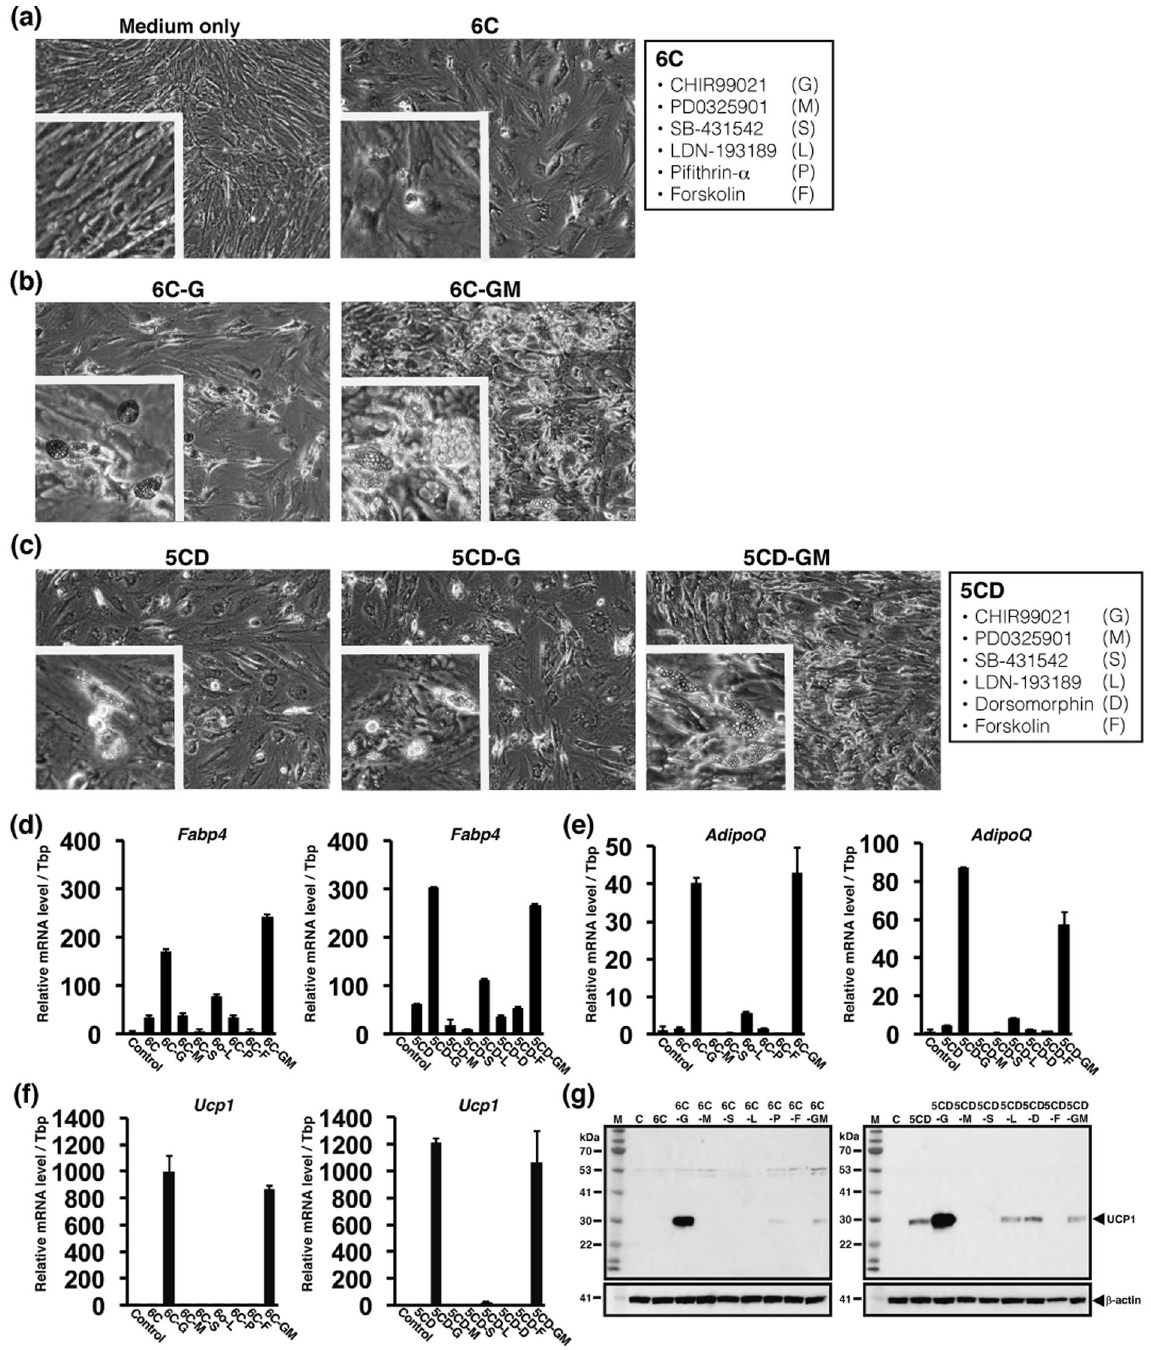
Figure 1. Identification of chemical compounds for direct conversion from HDF38 fibroblasts to adipocyte-like cells. Effects of chemical compounds were evaluated 3 weeks after the treatment. ( a ) Images after the treatment using the adipocyte medium only or the adipocyte medium supplemented with the 6 chemical compounds (6C). Insets show higher magnification. ( b ) Morphologies after cultivation with the adipocyte medium and the chemical cocktail excluding either CHIR99021 (G) or CHIR99021 and PD0325901 (GM) from 6 C. Insets show adipocyte-like cells. ( c ) Images after treatment with the adipocyte medium with 5 CD (5C supplemented with Dorsomorphin (D)) (left panel), and the adipocyte medium with chemical cocktails excluding either G (middle panel) or GM (right panel) from 5CD. Insets show adipocyte-like cells. qRT-PCR analyses of adipocyte- specific genes, Fabp4 ( d ) and AdipoQ ( e ), and a brown adipocyte-specific gene, Ucp1 ( f ), after cultivation with the adipocyte medium only (Control) and the medium supplemented with each combination of the chemical compounds as indicated. ( g ) UCP1 protein levels were evaluated by western blotting analysis. HDF38 fibroblasts were cultured as described above. β -actin is a loading control. “M” and “C” indicate a molecular weight marker and the control, respectively. Data represent mean ±